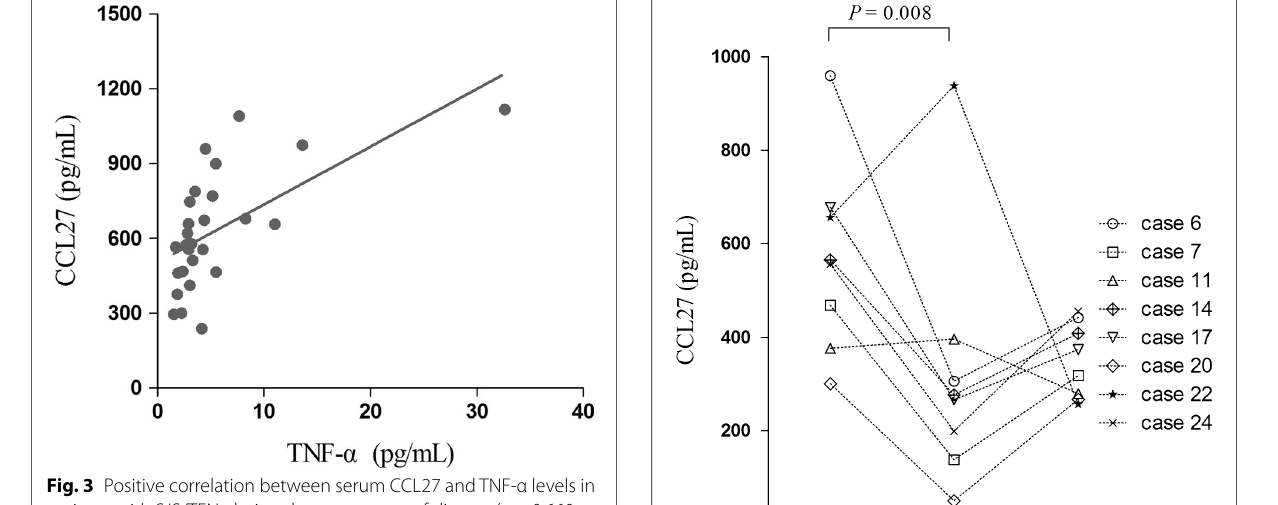
0.660, = TEN. Each symbol represents the cytokine concentration from a patient. Case 7 and case 22 were the 2 patients with TEN. Statisti‑ cal significance was determined by Student’s t test. A acute stage, B blister, R resolution